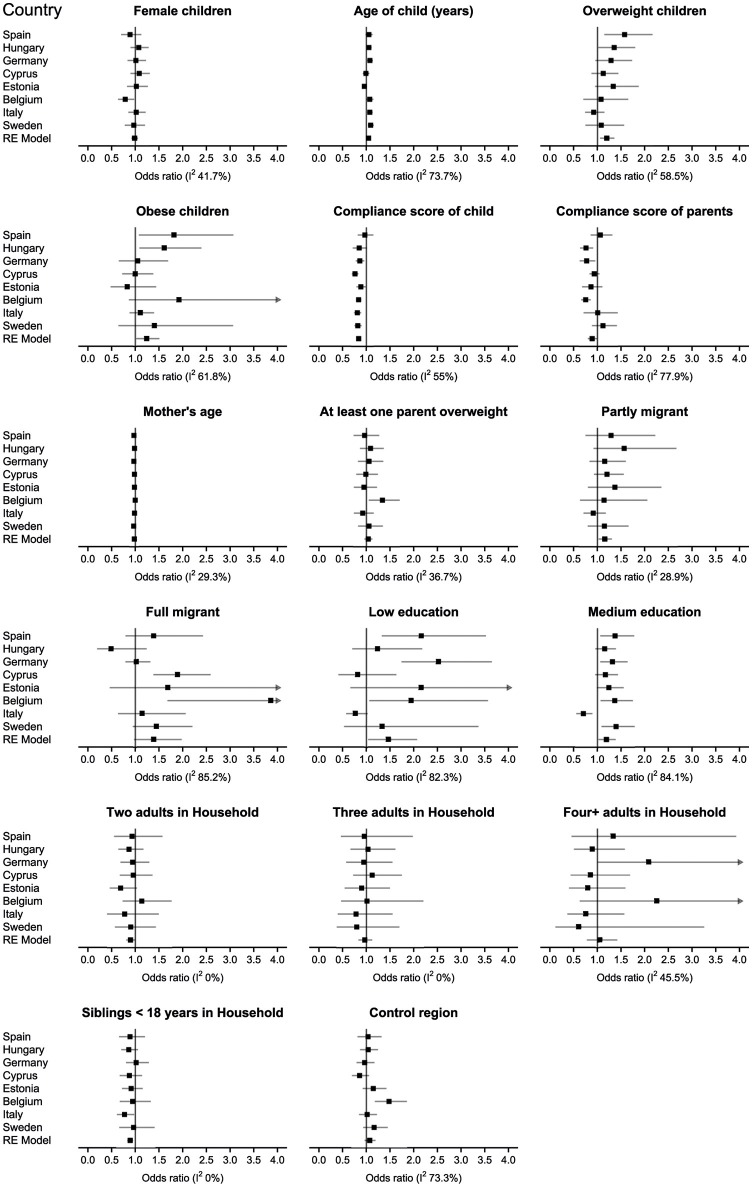
Odds ratios for attrition (with 99% confidence intervals, CI) from country-stratified logistic regression models (ordered by baseline response) with attrition as dependent variable and same predictors as in the random intercept logistic regression model (Table 3) as well as a pooled estimate of a random-effects meta-analyses (RE model), and I2 (%) as a measure of heterogeneity between the countries. I2 values above 50% indicating substantial heterogeneity were observed for 9 out of 17 variables. Arrows at the upper limit of a CI: SD, standard deviation confidence interval extends past four.